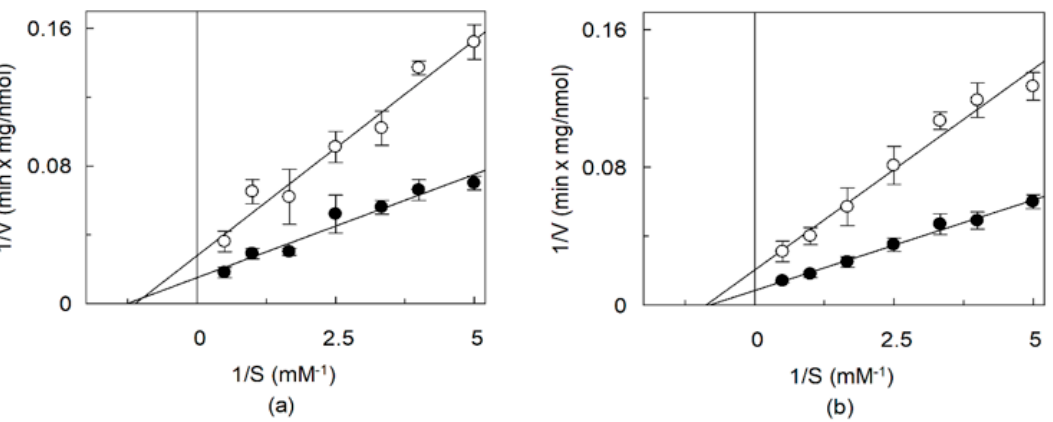
Figure 8. Effect of CHS on OCTN1 transport kinetics. The recombinant OCTN1 was reconstituted in liposomes as described in Section 4.5. except that in the absence ( ○ ) or in the presence ( ● ) of 8.3% CHS corresponding to 83 µg CHS/mg total lipids. The transport rate was measured adding [ 14 C]-TEA ( a ) or [ 3 H]-acetylcholine ( b ) at the indicated increasing concentrations to proteoliposomes. The transport reaction was stopped at 10 min. Data were plotted according to Lineweaver–Burk as reciprocal transport rate vs reciprocal TEA ( a ) or acetylcholine ( b ) concentration. The values are means ± SD from three experiments.